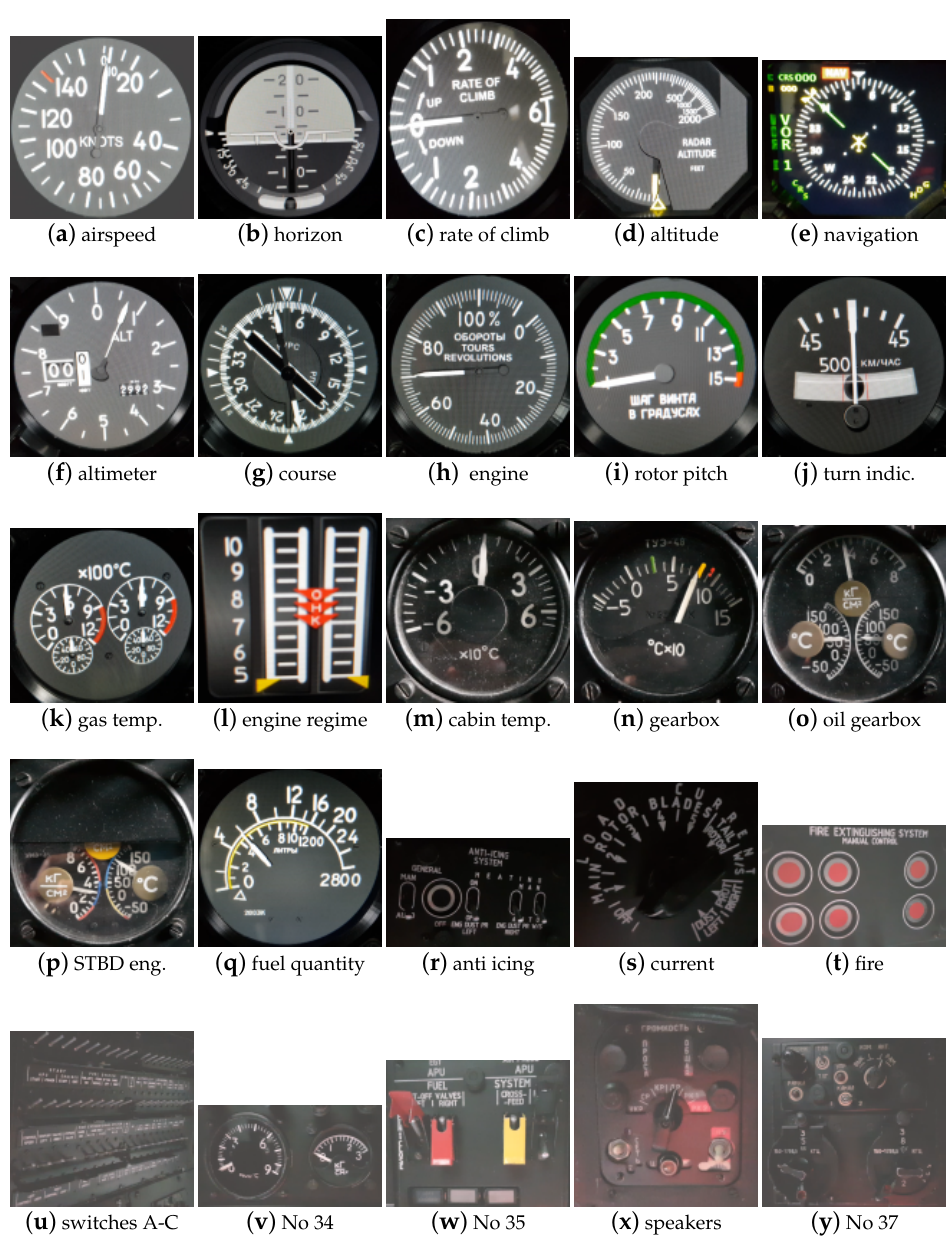
Figure 3. WrightBroS database class